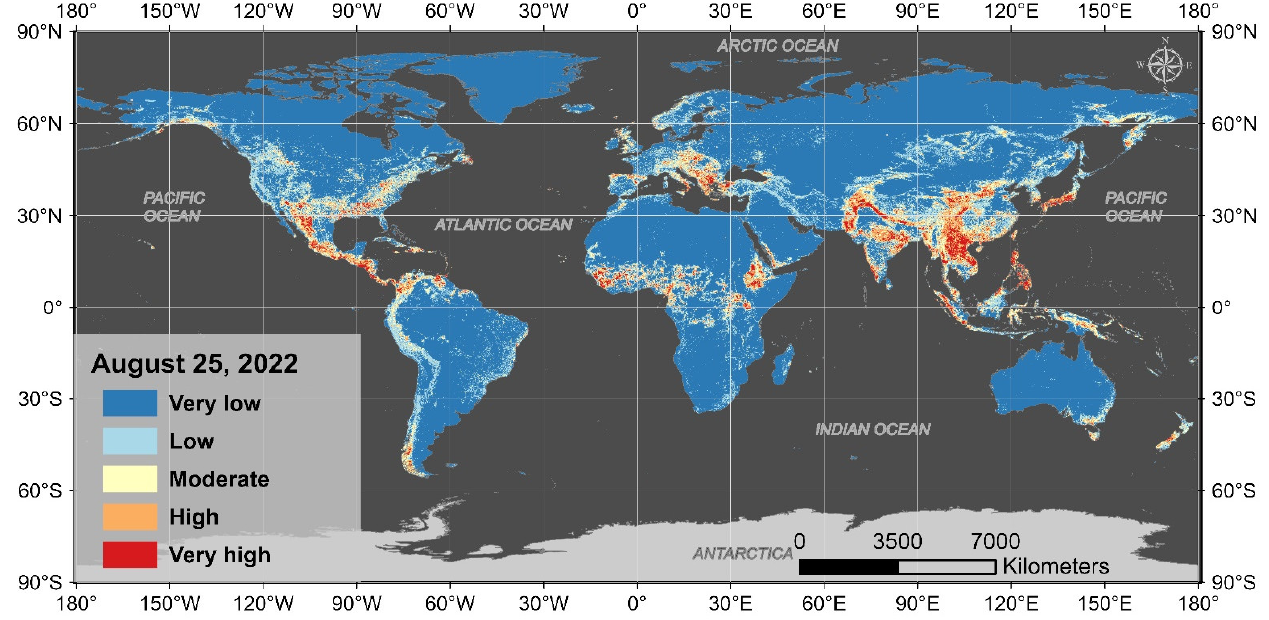
Figure 9. Landslide susceptibility prediction result for 25 August 2022.